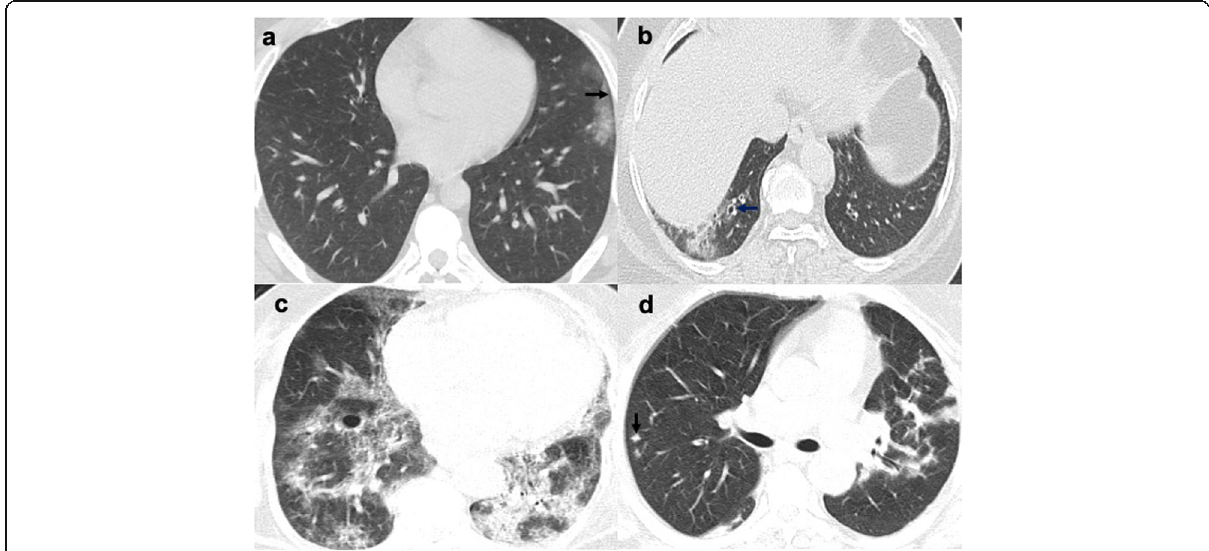
Fig. 5 Axial chest CT lung window in cases with COVID-19 pneumonia. a The patchy ground-glass density with subpleural lucent line (arrow). b Right patchy ground-glass opacity, bronchial dilatation, and thickening (arrow). c The bilateral ground-glass densities and consolidation, with a right lower lobe cyst and a right apical segment LL angulated shape well-defined nodule ( d )